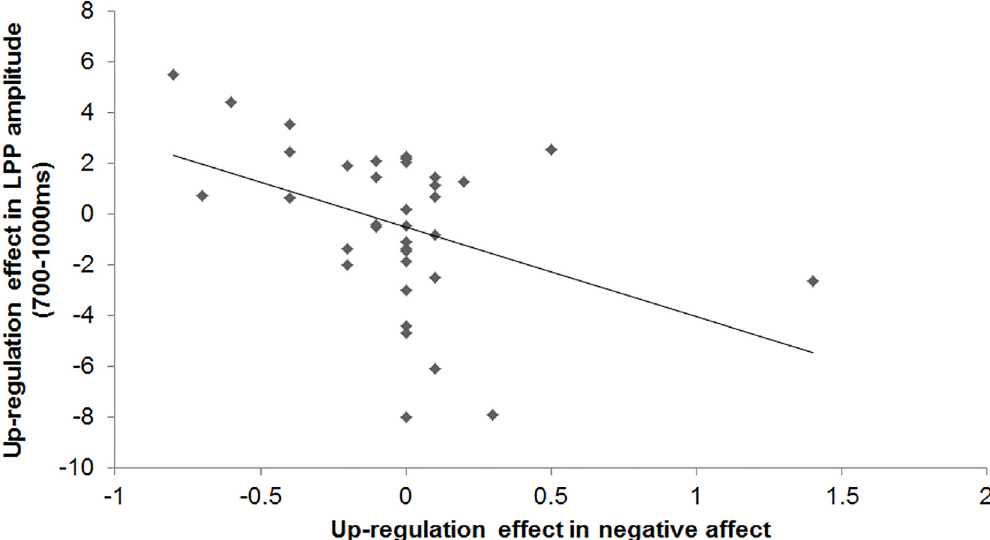
Fig 8. Scatterplot displaying the negative correlation between the up-regulation effect in the LPP amplitude (averaged across electrodes Cz and Pz) between 700 – 1000 ms and the up-regulation effect in negative affect. A negative up-regulation effect in negative affect means a reduction in negative affect due to love up- regulation. A positive up-regulation effect in the LPP amplitude means that the LPP was enhanced for love up-